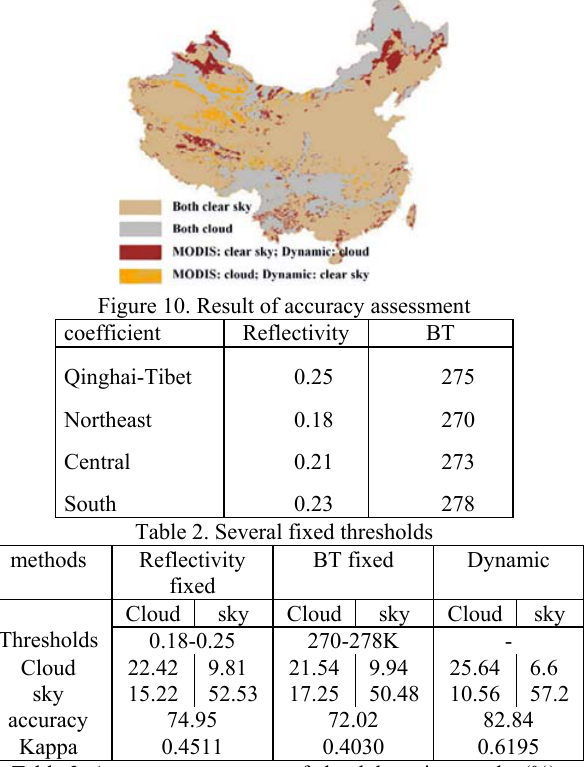
Table 3. Accuracy assessment of cloud detecting results